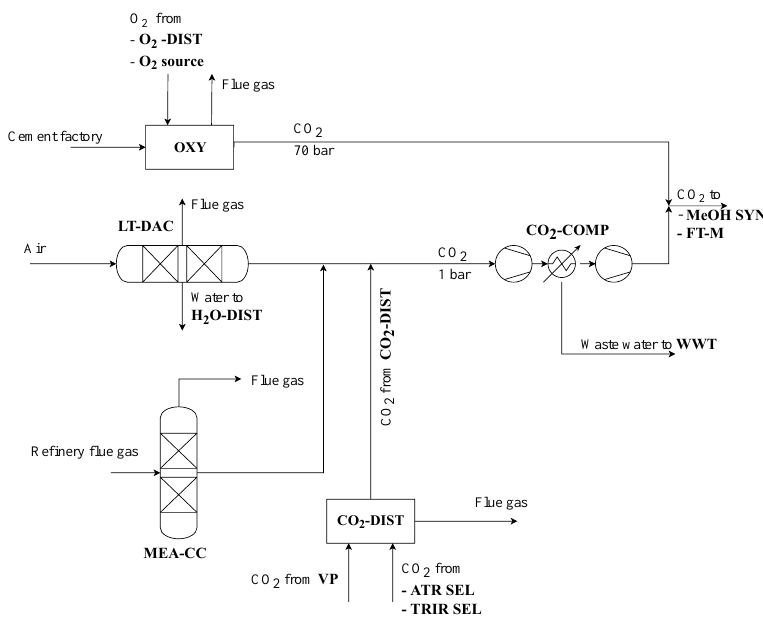
Figure 2. Carbon capture process section of the superstructure.